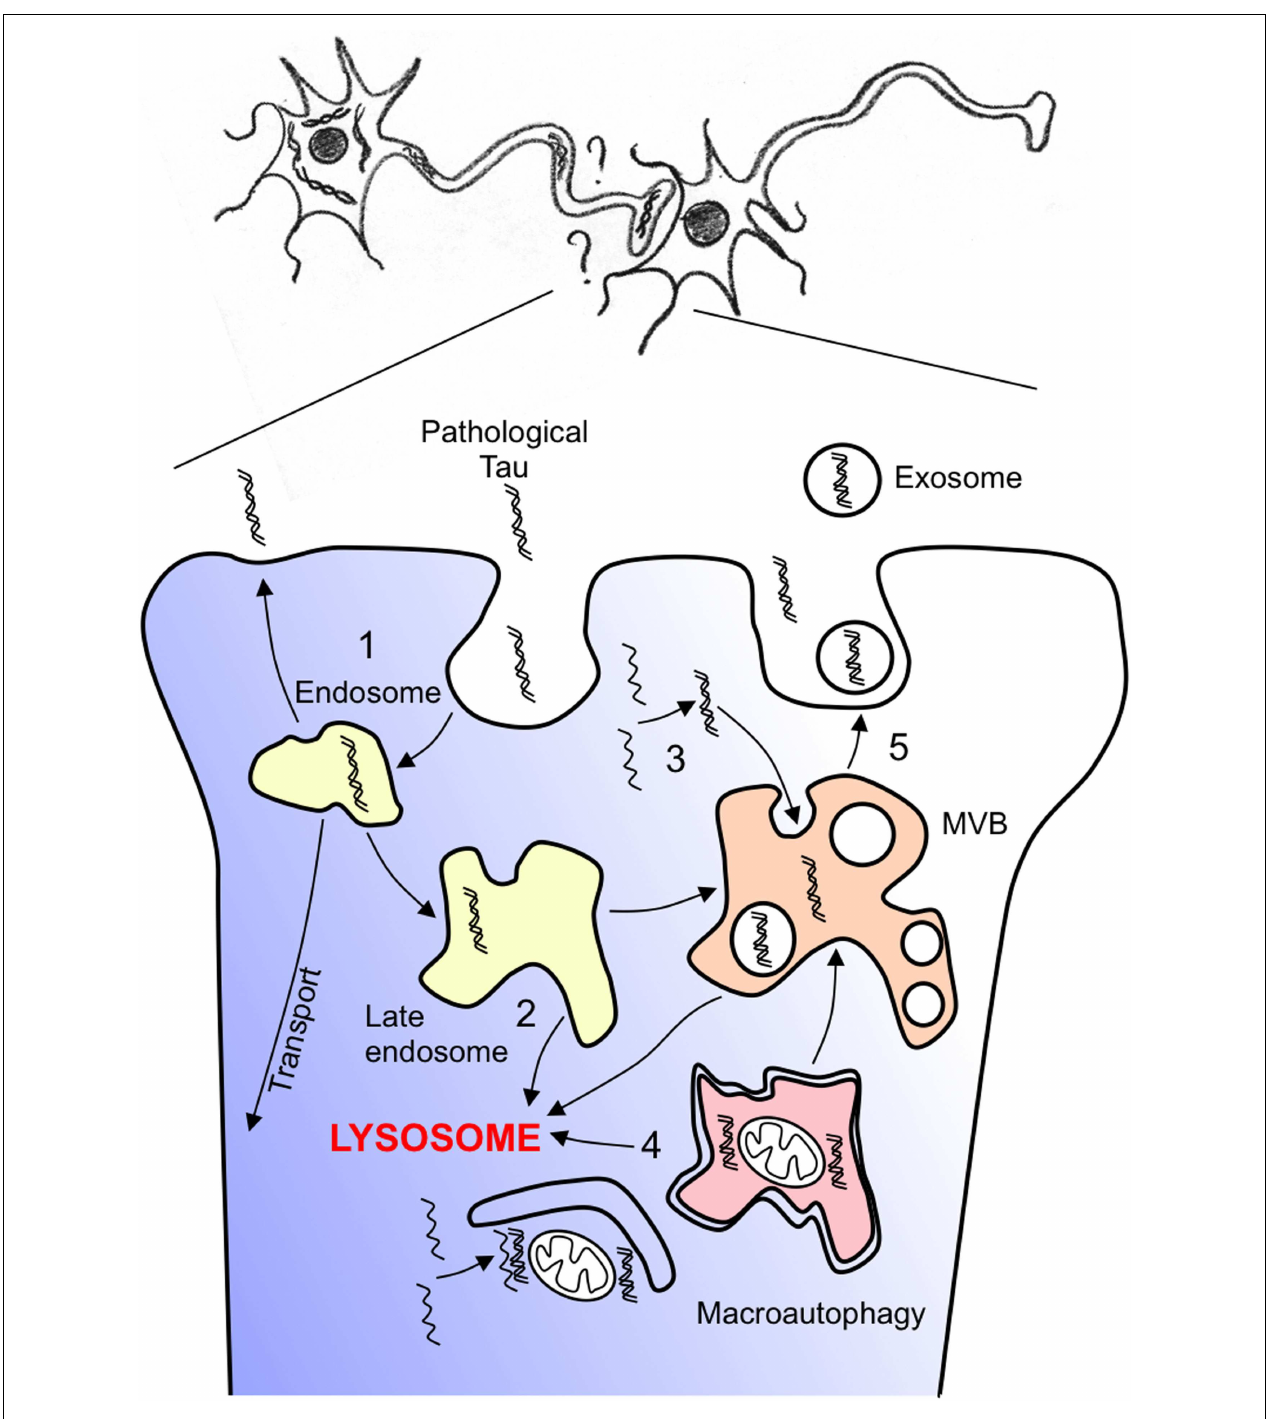
(3) Pathological tau species that are produced in the cell soma are included into multivesicular bodies by inward budding of the late endosome membrane (4) Pathological tau species can be included into large autophagic vesicles by macroautophagy and further fused with multivesicular bodies (5) pathological tau species can be release by fusion of multivesicular bodies with the plasma membrane at the synaptic junction and capture by the connected dendrite.